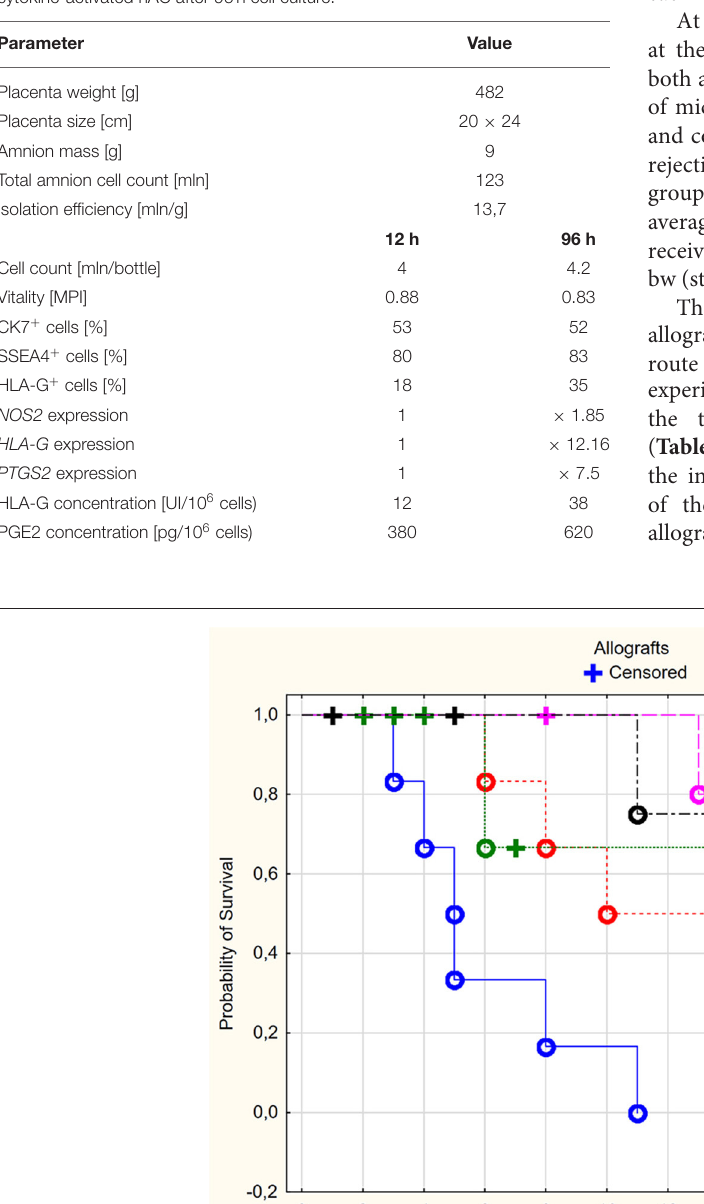
TABLE 3 | Quantitative and qualitative analysis of non-activated and cytokine-activated hAC after 96h cell culture.